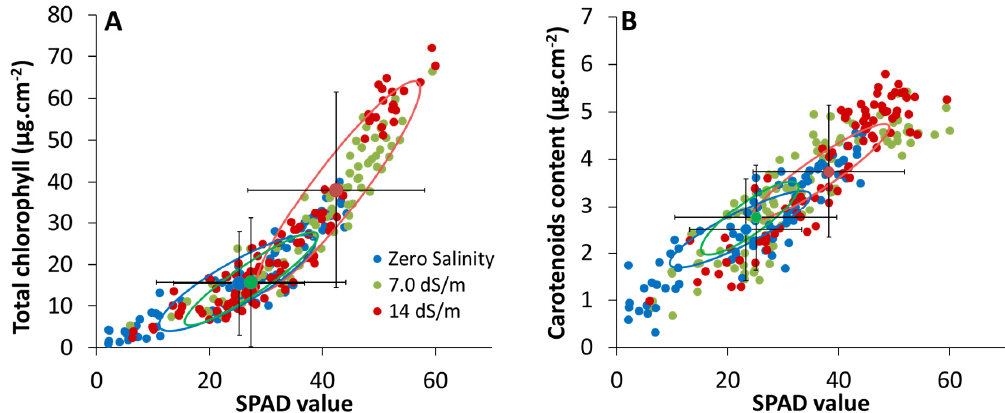
Figure 5. Cluster analysis of the relationships between SPAD-502 reading and the pigments at various levels of salinity and fertilizer application. ( A ) SPAD vs. total chlorophyll, ( B ) SPAD vs. total carotenoids content. The ellipses are calculated from the covariance matrix of the relationships. Whisker plots are superimposed on the data to illustrate the data spread ( n = 277).